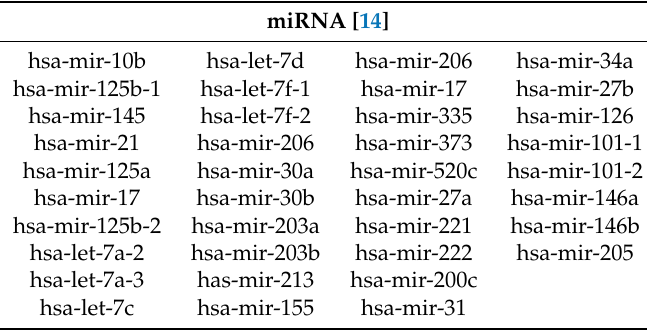
Table 1. Clinically Verified